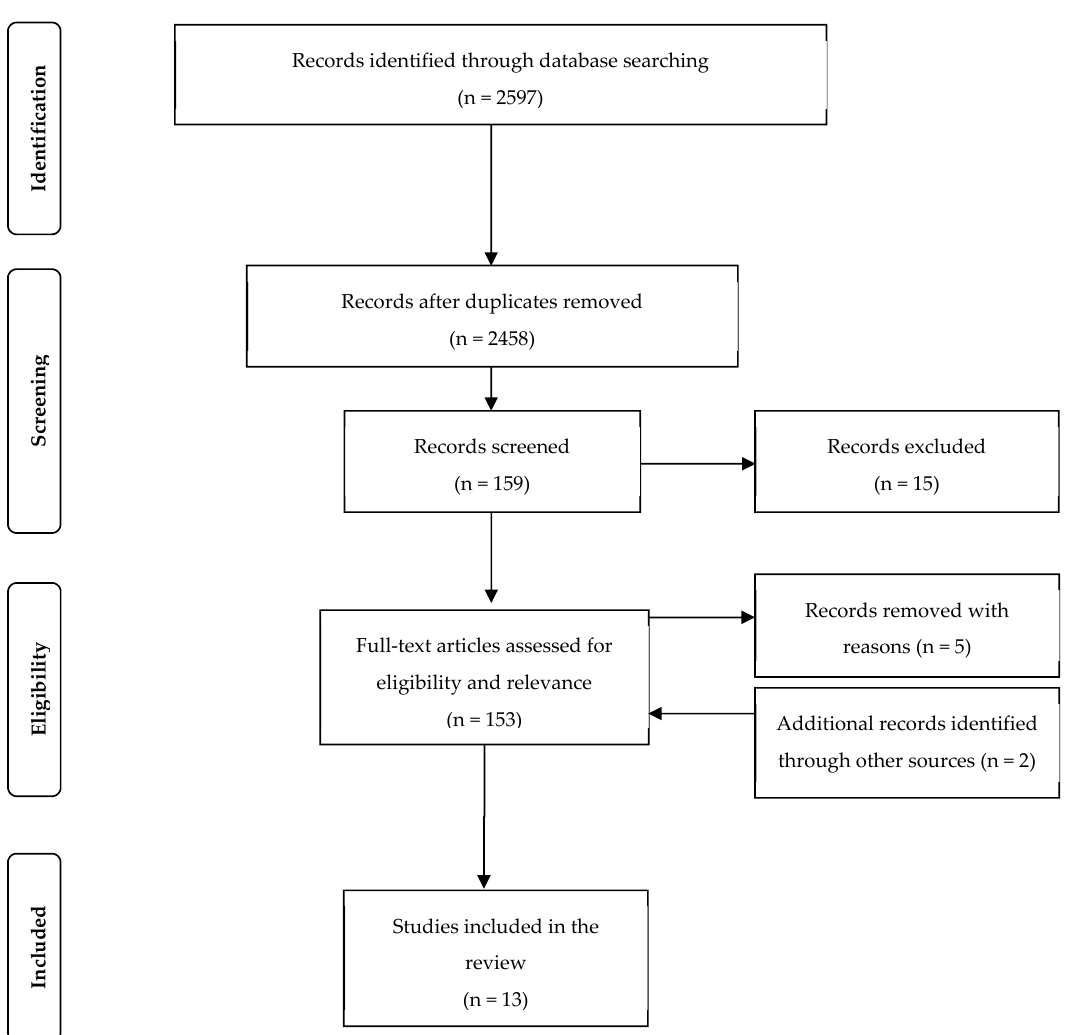
Figure 1. PRISMA diagram of selection of studies reviewed in this paper.